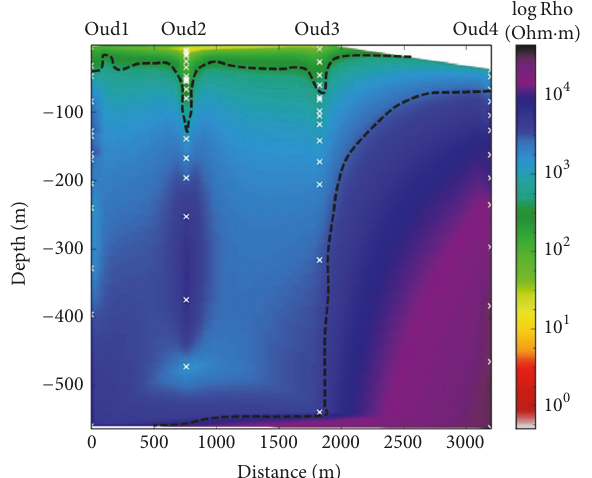
Figure 14: Geoelectrical section of Oudou profile at 600 meters’ depth.